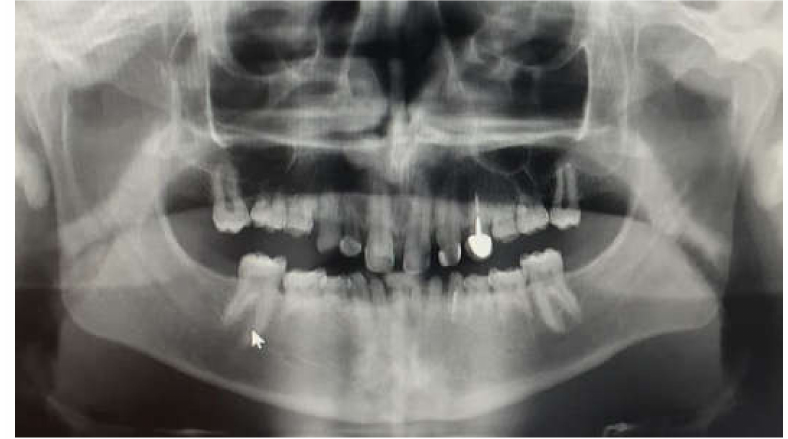
Figure 7. Panoramic pre-operative X-ray.